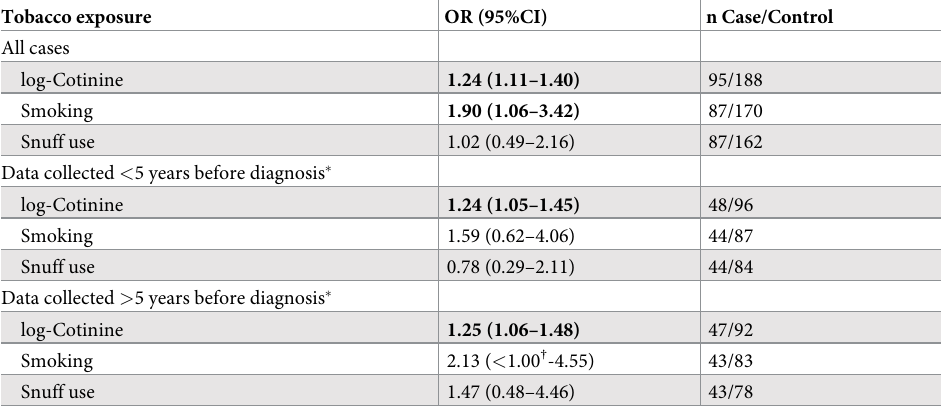
Table 3. Conditional logistic regression, univariable odds ratios (OR) and 95% confidence intervals (CI) for devel- oping inflammatory bowel disease, subdivided by median time from data collection to diagnosis. Tobacco exposure OR (95%CI) n Case/Control All